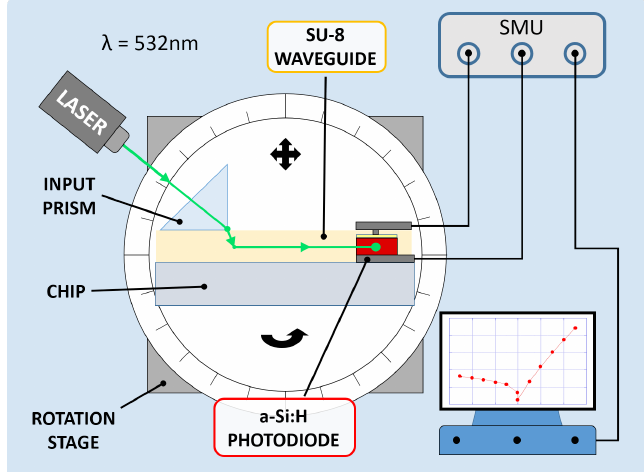
Figure 8. Electro-optical characterization